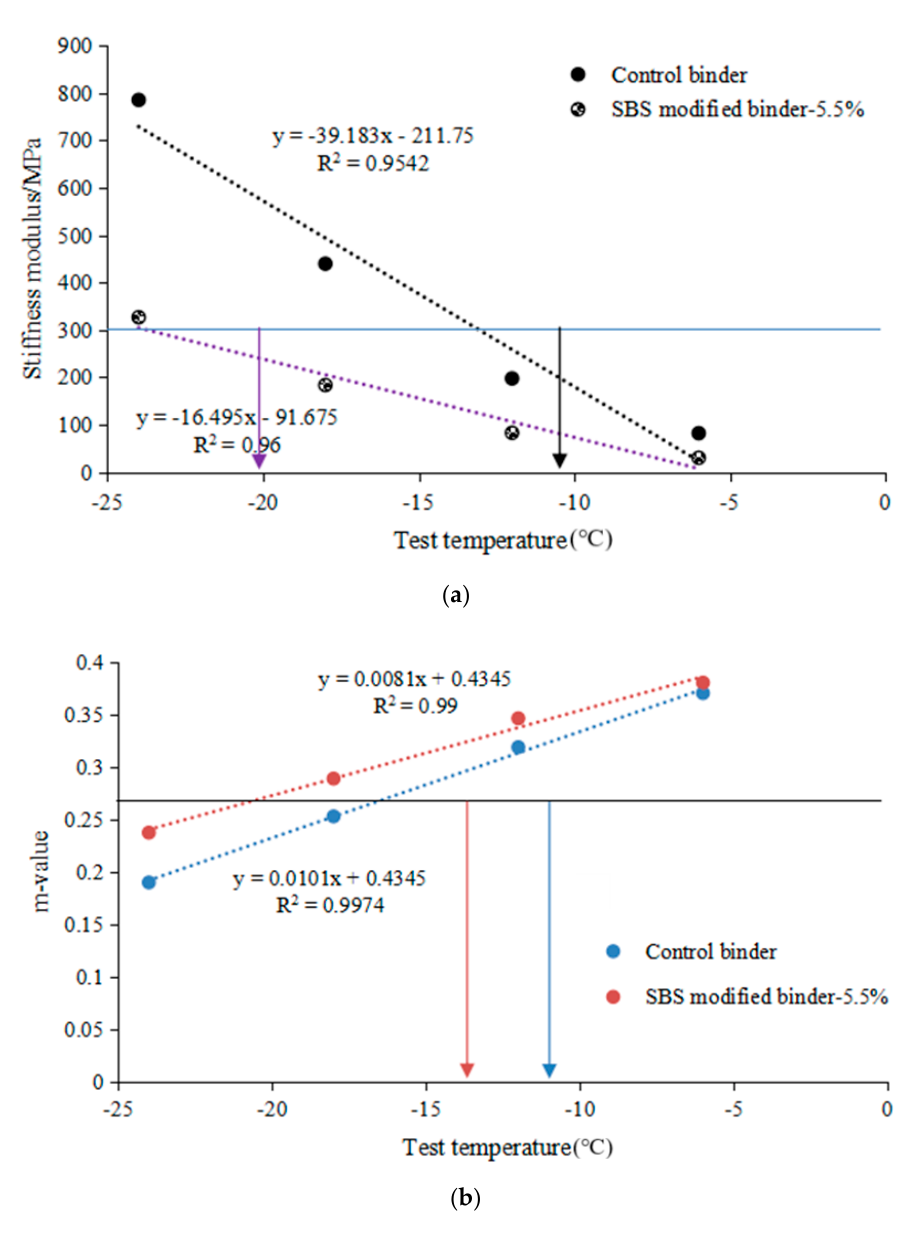
Figure 1. Stiffness values and m-values of SBS modified binders produced with binder source A70 versus test temperature: ( a ) Stiffness values; ( b ) m-values.